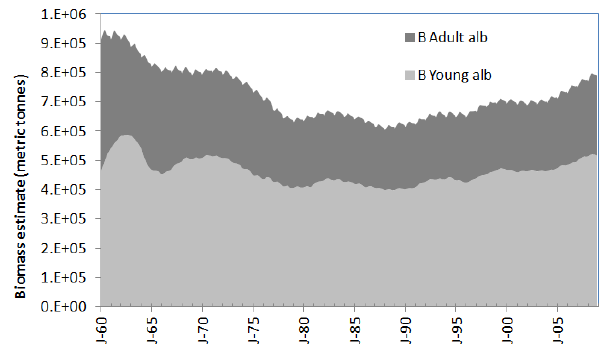
Figure 7. Total biomass estimate for young immature (light grey) and adult mature (dark grey) of the North Atlantic albacore stock.